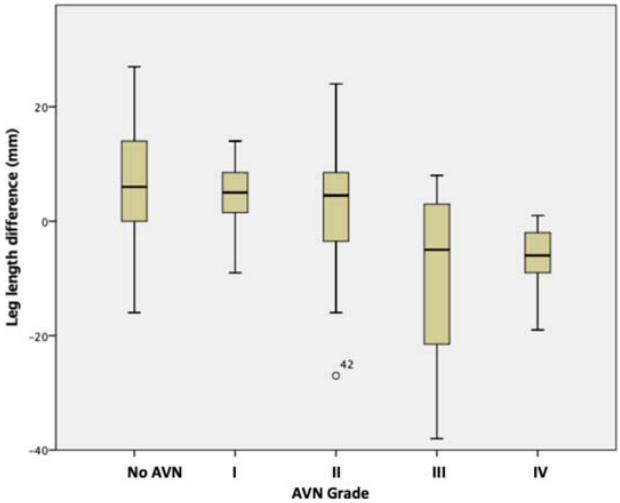
Figure 4. The average leg length difference between the DDH leg and the unaffected leg, grouped by AVN grade.